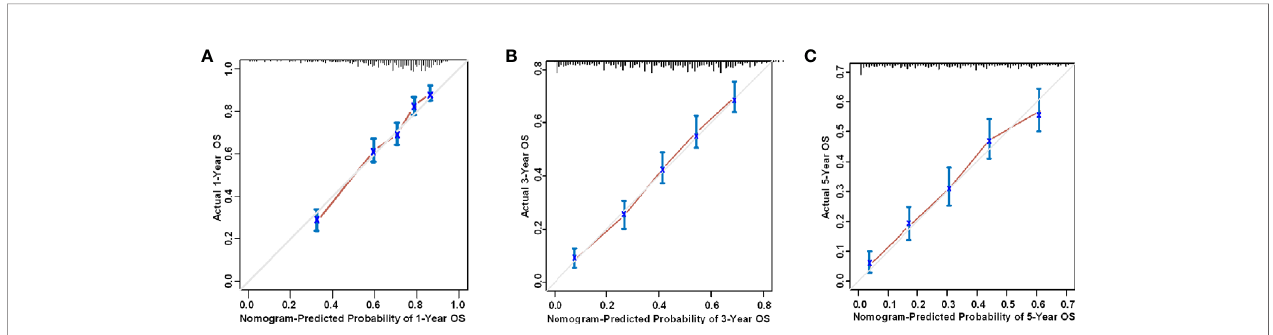
FIGURE 5 | Internal calibration curve of the nomogram for the prediction of the (A) 1-year, (B) 3-year, and (C) 5-year survival probability of HSCC